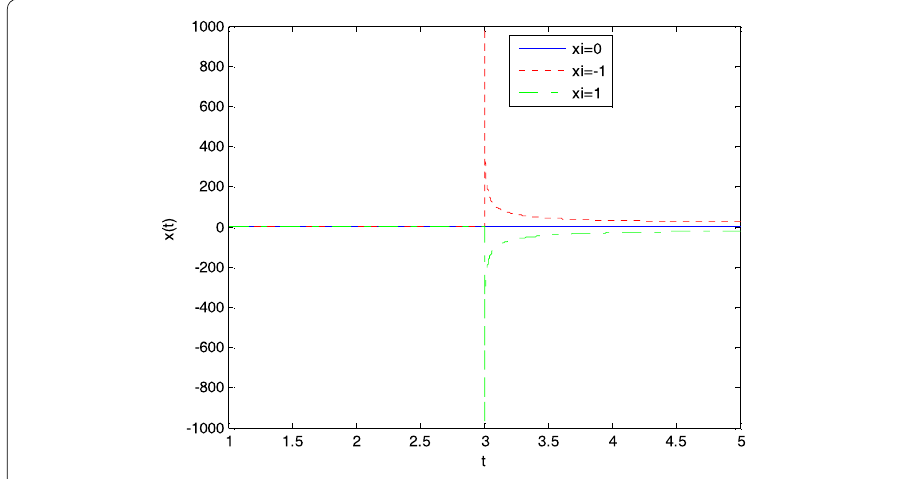
Figure 1 The solution trajectory of system (5.1) with ρ = 0.1